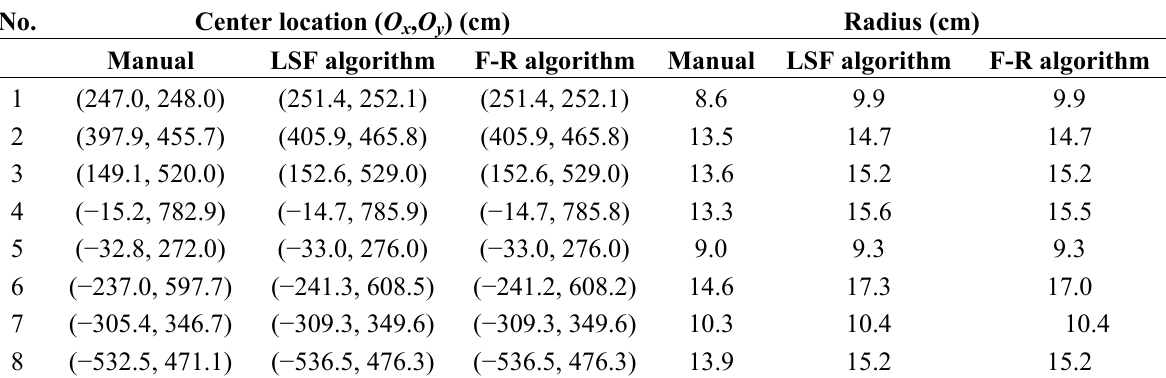
Table 1. The parameters of the trunks acquired by different methods.